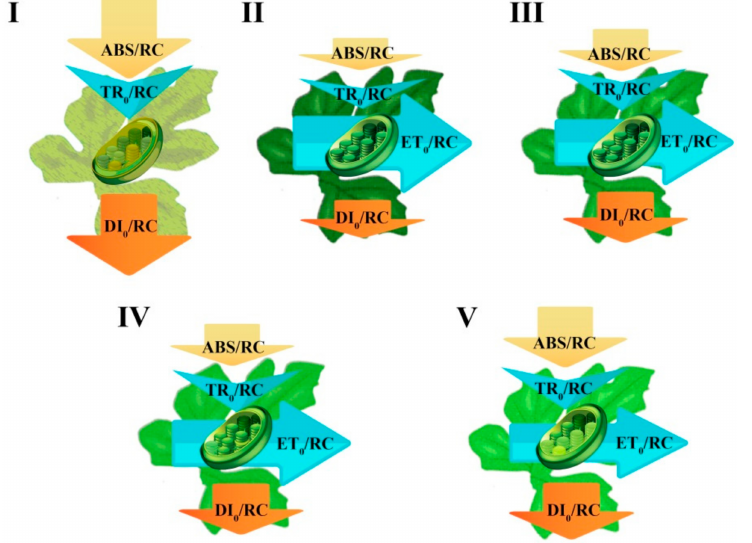
Figure 9. Energy pipeline models of grafted watermelon seedlings exposed for 12 days to either darkness (D; I ) or different light quality regimes [blue (B; II ), white (W; III ), red and blue (RB; IV ), as well as red (R; V ); see spectrum and parameters’ equations in Supplementary Figure S3 and Table 2, respectively]. Photosynthetic photon flux density was 20 ± 1 µ mol m − 2 s − 1 during the first 2 days, and 50 ± 1 µ mol m − 2 s − 1 during the following days. The relative magnitude of each activity or fluctuation is shown by the size of the corresponding arrow. The intensity of green color of the leaves and chloroplasts illustrates their overall health